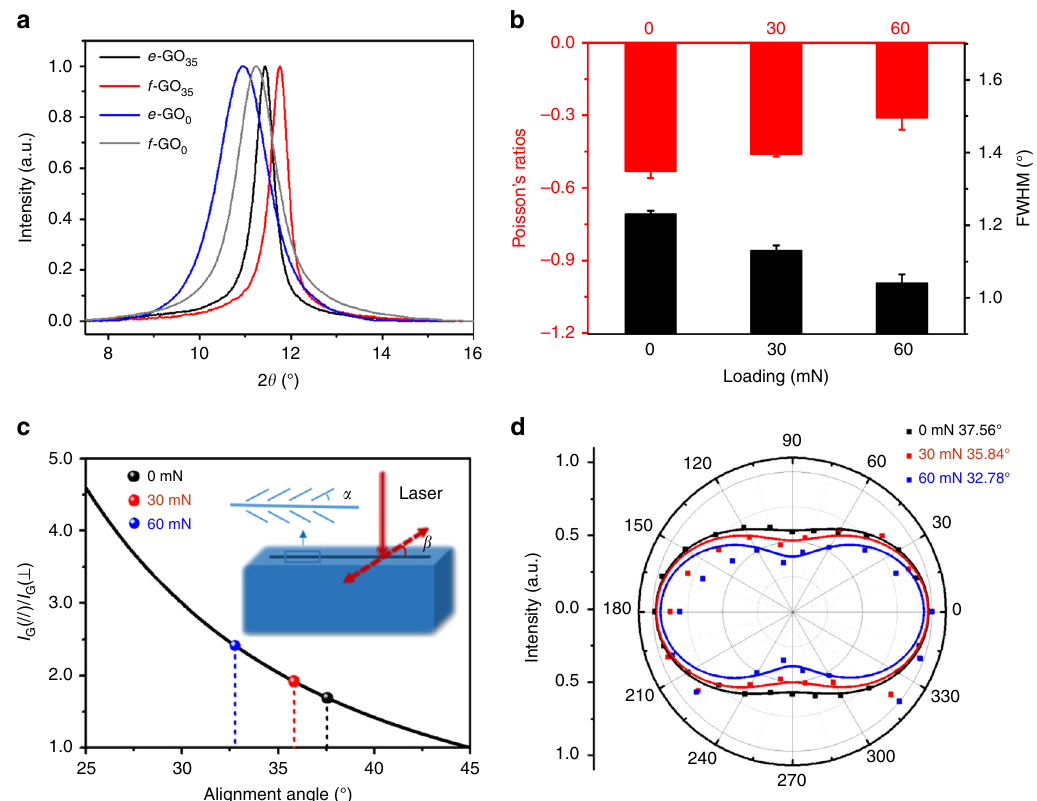
Fig. 3 Microstructural origins of the negative Poisson ’ s ratio (NPR) effect. a X-ray diffraction patterns of the e -GO 35 , f -GO 35 , e -GO 0 , and f -GO 0 fi lms. b Poisson ’ s ratios and the full-width at half-maximum (FWHM) measured for the e -GO 0 fi lms under different amplitudes of pre-stretch. c Relationship between the value of I G (//)/ I G ( ⊥ ) and the angle of sheet ( α ) in the fi lms (inset: the polarized Raman setup). d The G band intensity, I G ( β ), plotted as a function of β . Black dots and lines are the experimental data of e -GO 0 fi lms without pre-stretch and the fi tting curve using Eq. (2), while the red (blue) ones are the data and fi tting curve for e -GO 0 fi lms under 30 (60) mN pre-stretch. The error bars in panel ( b ) indicate the standard errors (three samples for the Poisson ’ s ratios and four samples for FWHM). Source data are provided as a Source Data fi